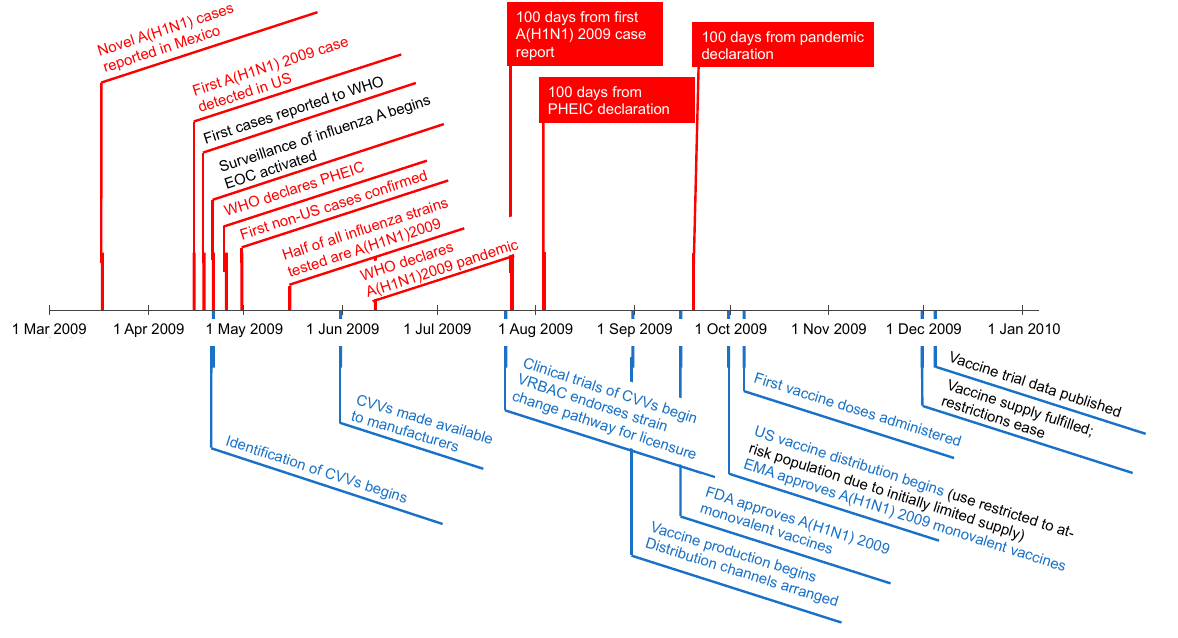
Figure 1. Timeline of A(H1N1)2009 pandemic. Pandemic-related events are in red type; vaccine development–related events are in blue type [17,18,27,29–31]. ACIP, US Advisory Committee on Immunization Practices; CDC, US Centers for Disease Control and Prevention; CVV, candidate vaccine viruses; EMA, European Medicines Agency; EOC, CDC Emergency Operations Center; PHEIC, public health emergency of international concern; VRBAC, Vaccines and Related Biological Advisory Committee; WHO, World Health Organization.